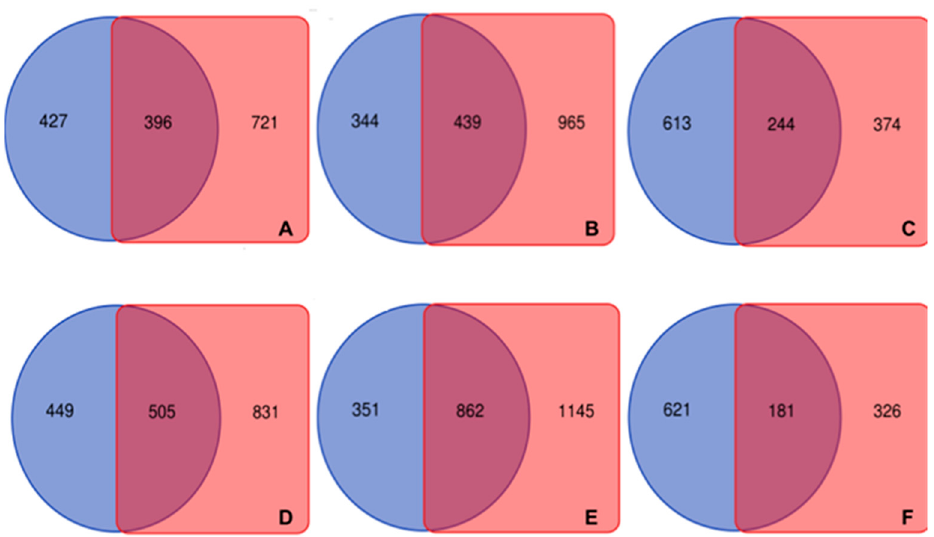
Figure 6. BLASTN comparison of copa í ba lncRNA aligned to each species genome and complementary DNA (cDNA): In the venn diagram is compared the amount of copa í ba transcripts aligned to the genome (blue circle), to the transcriptome (red square) or to both (overlapped area). ( A ) is the V . unguiculata comparison, ( B ) is M . truncatula , ( C ) is P . vulgaris , ( D ) is L . japonicus , ( E ) is G . max and ( F ) is C . reticulatum . It is possible to observe that G. max, L japonicus and M . truncatula presented a higher number of overall aligned transcripts and also overlapped